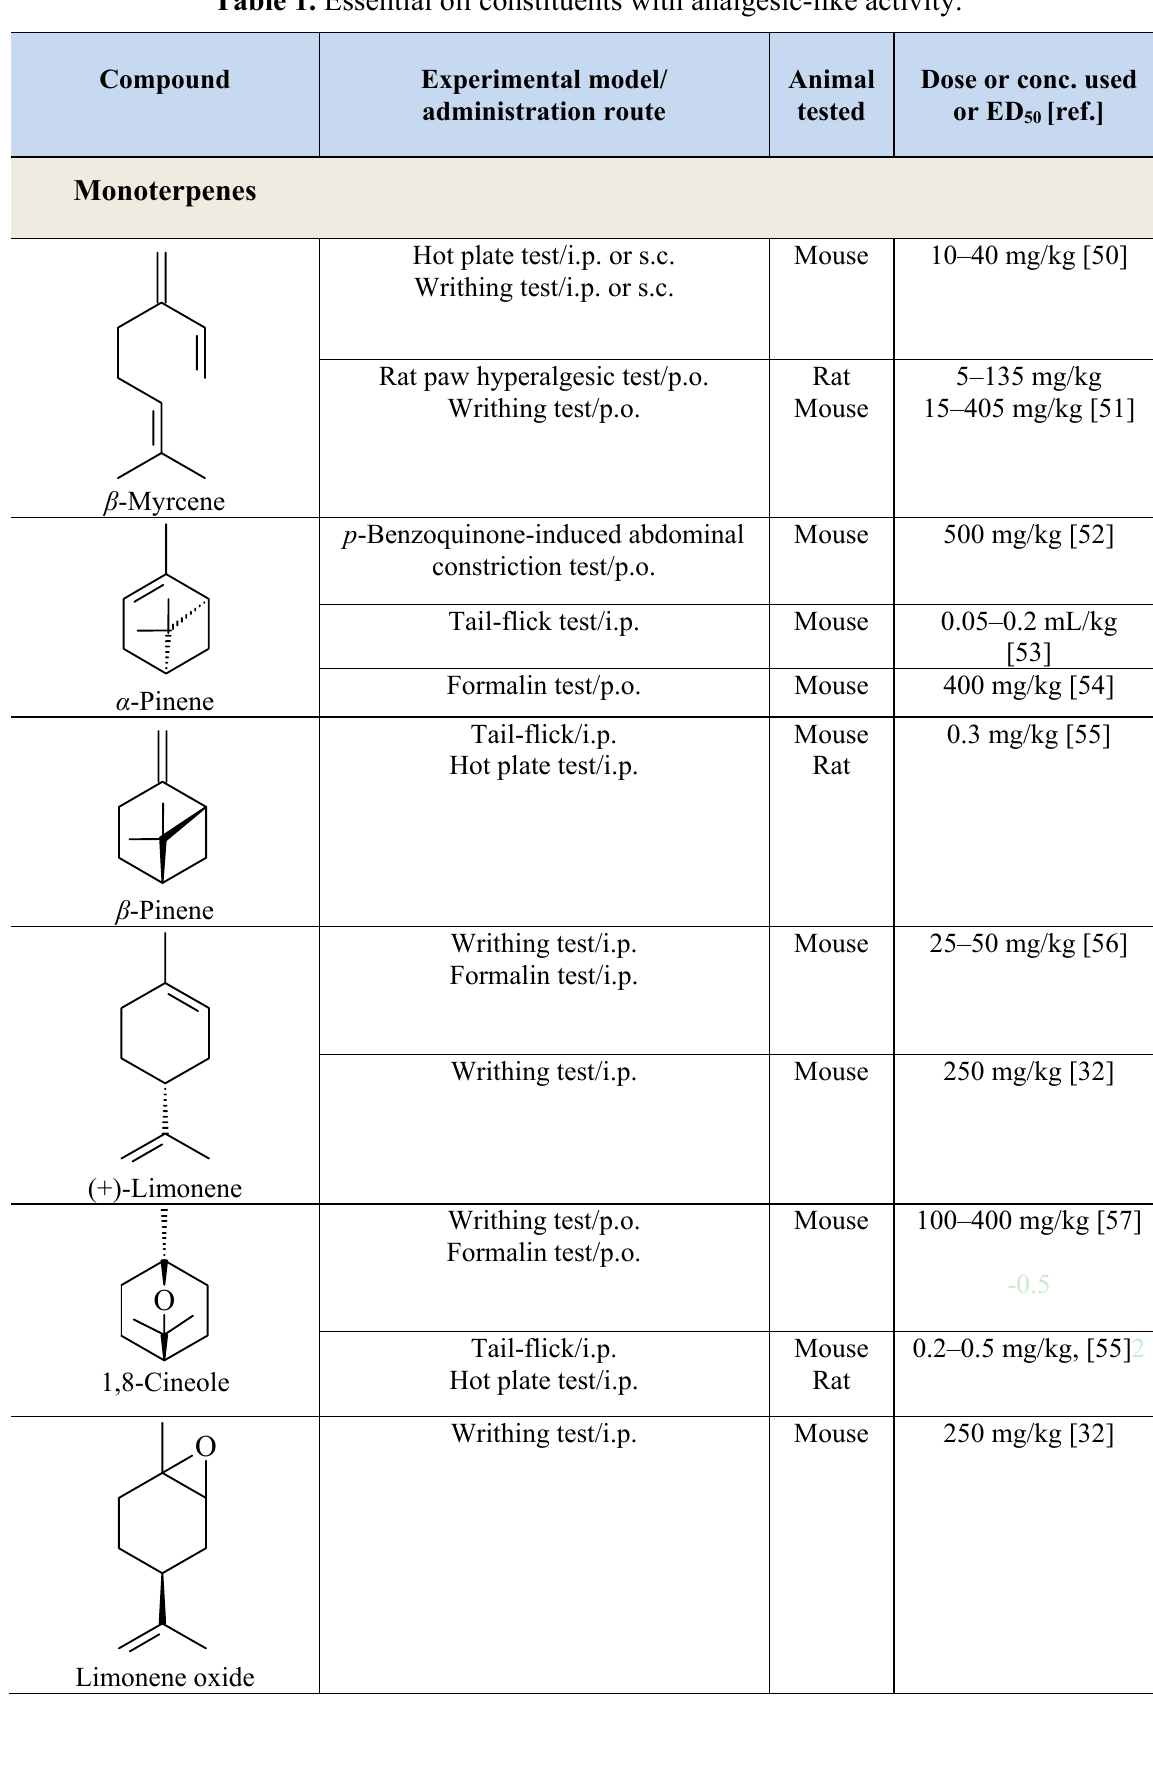
Table 1. Essential oil constituents with analgesic-like